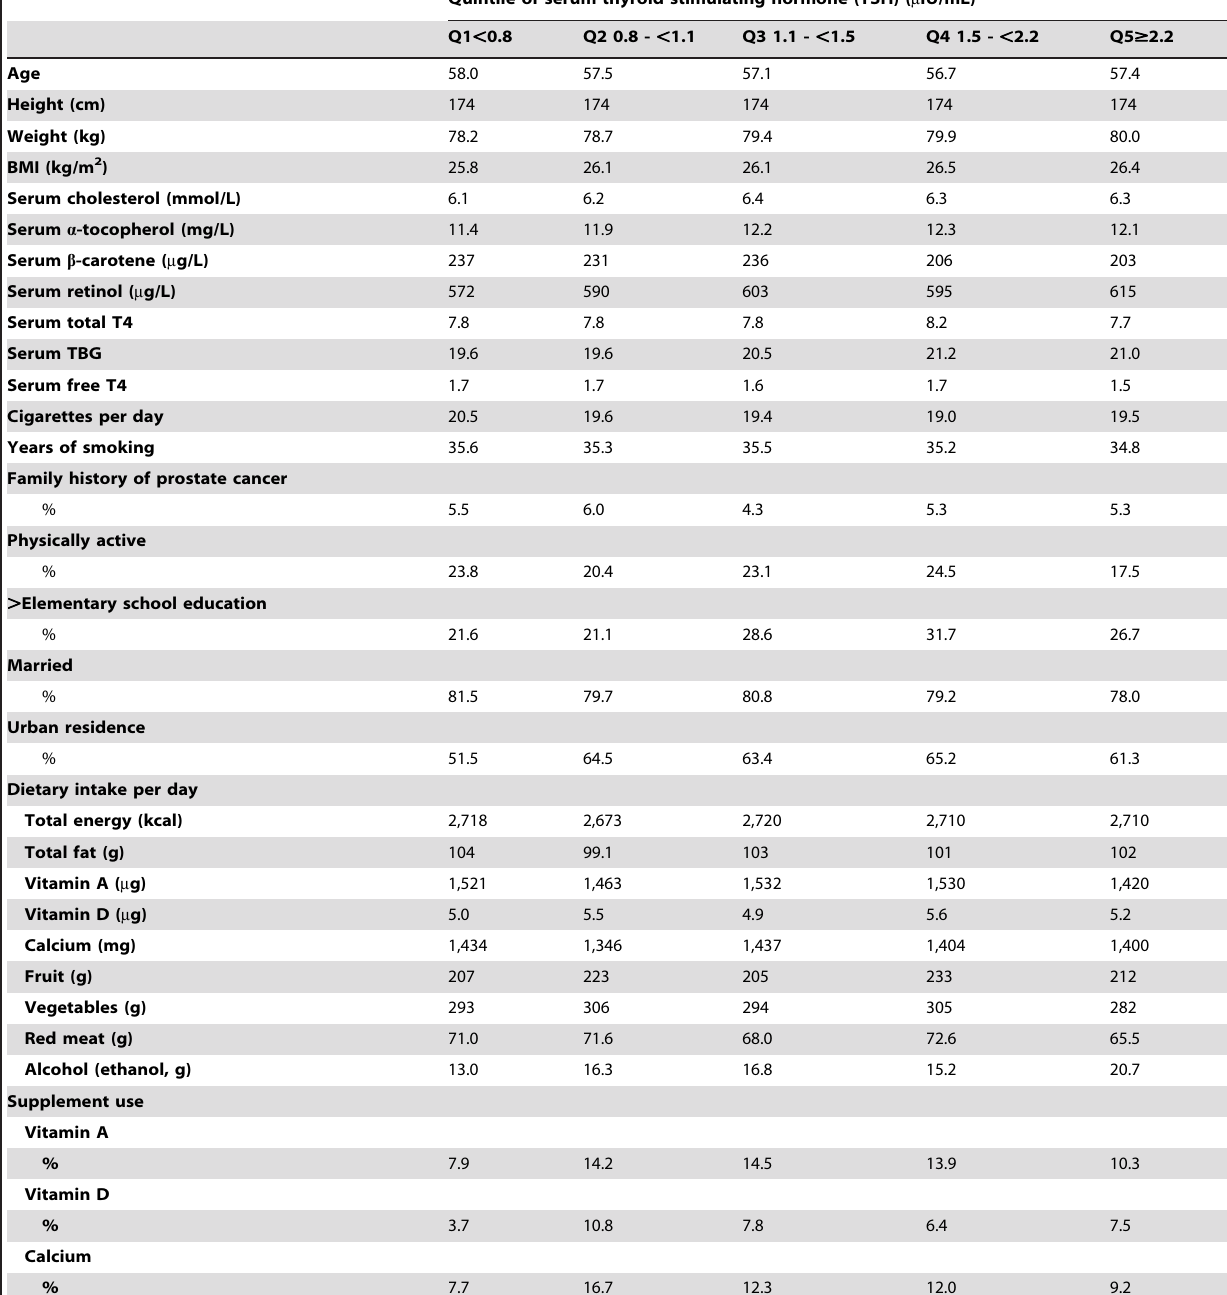
Quintile of serum thyroid stimulating hormone (TSH) ( m IU/mL) Q1 , 0.8 Q2 0.8 - ,